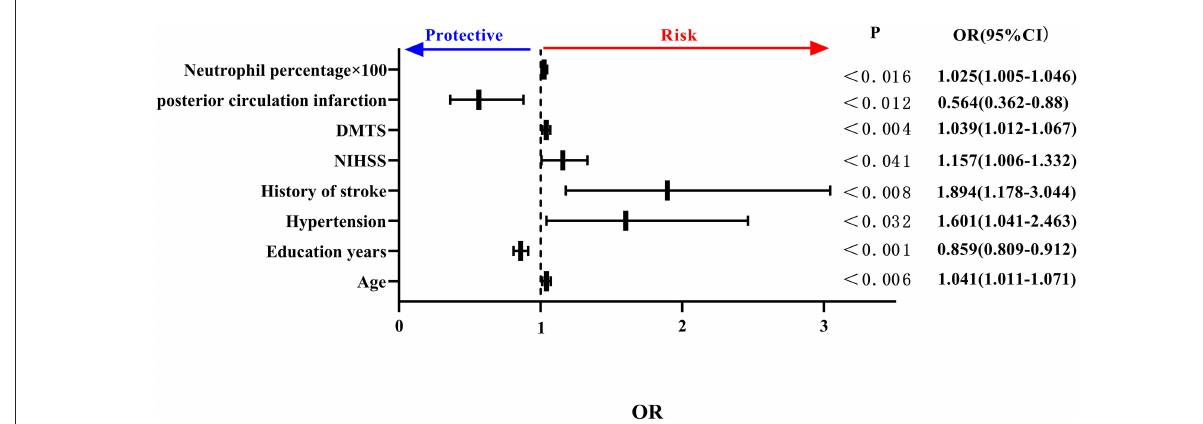
FIGURE3 Forest plot of PSCI impact factors (incorporating percentage of neutrophils). PSCI, post-stroke cognitive impairment.